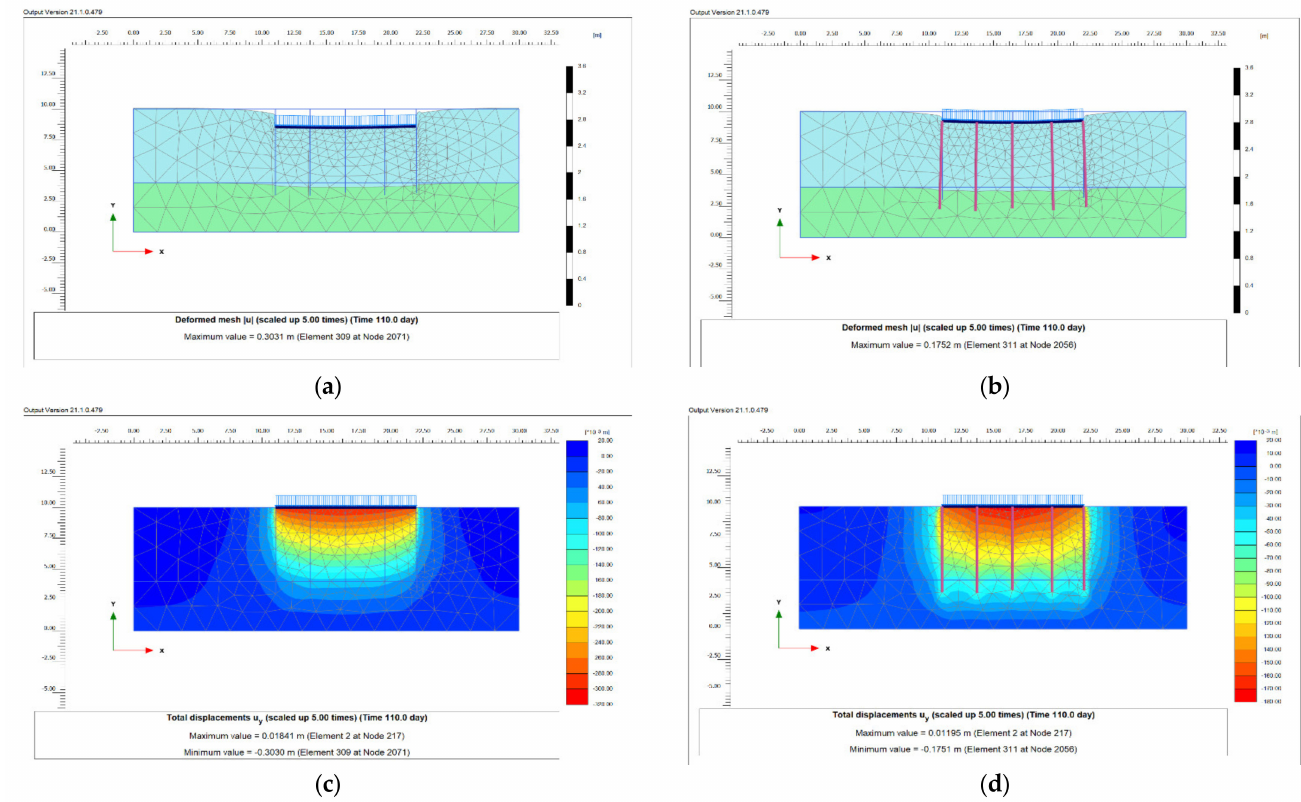
Figure 11. Hard strata at bottom, raft and piled raft: ( a ) deformed mesh of raft, ( b ) contours of displacement raft, ( c ) deformed mesh piled raft, and ( d ) contours of displacement piled raft.